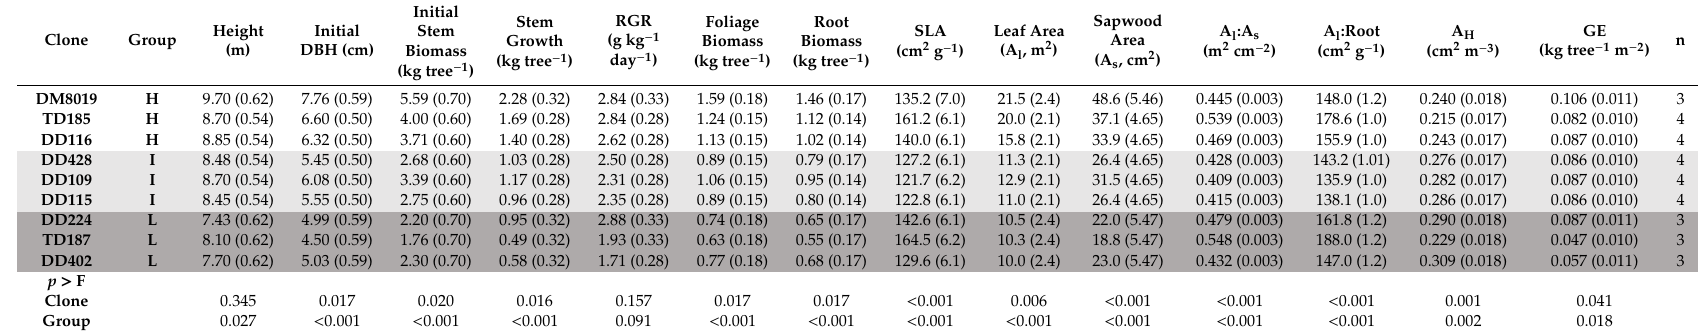
Table 1. Tree biomass and canopy structural characteristics for nine Populus clones. Stem, foliage, and root biomass were estimated using stand specific allometric equations 1 . Initial stem biomass is for DOY 152 and stem growth and relative growth rate (RGR) are biomass accumulation over the 146 day study period. Foliage, root biomass, SLA, tree leaf area ( A l ), sapwood area ( A s ), A l : A s , the ratio of A l to root biomass ( A l :Root), and the hydraulic allometry index ( A H ) were estimated for tree diameter in late June. Growth e ffi ciency (GE) is the ratio of stem growth and tree leaf area. Data are lsmeans (standard error). Genetic crosses are DD: P. deltoides × P. deltoides , DM: P. deltoides × P. maximowiczii , and TD: P. trichocarpa × P. deltoides . Cells with no shading, light shading, or dark shading, represent genotypes with high (H), intermediate (I), and low (L) growth potential,